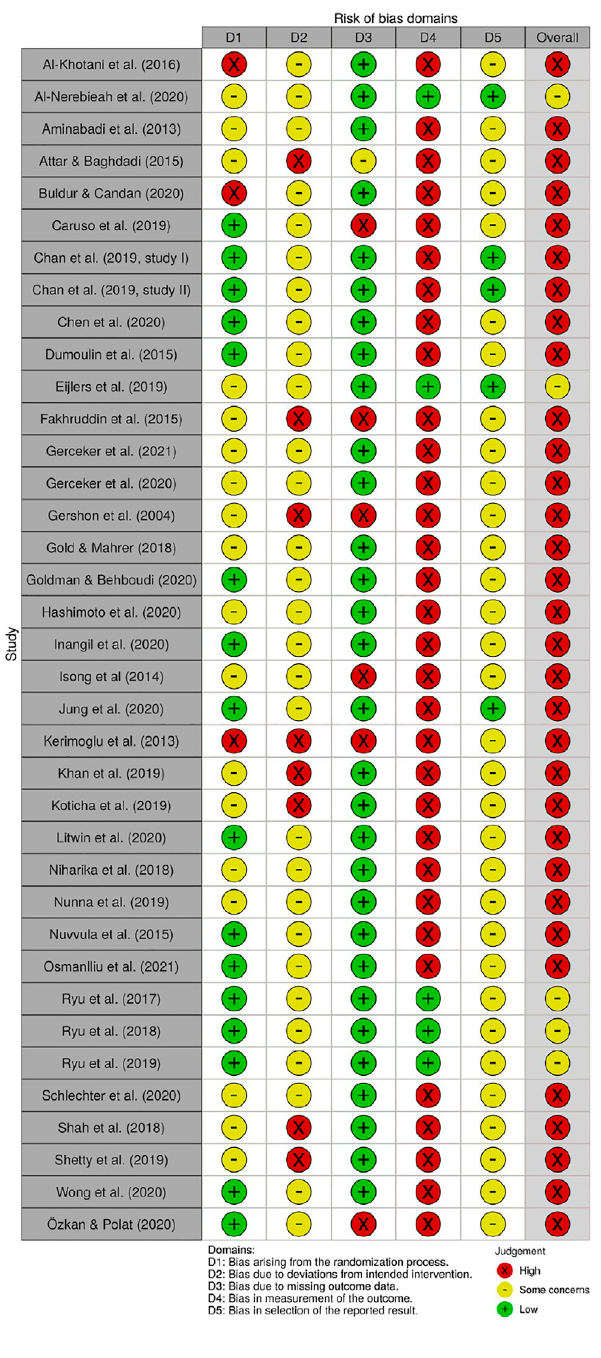
FIGURE 4 | Individual risk of bias judgements of randomized studies reporting anxiety